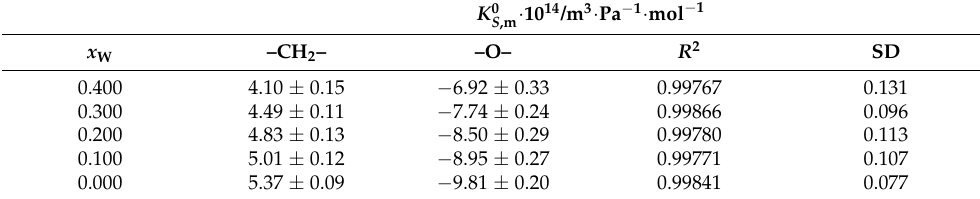
for glymes as a function S ,m